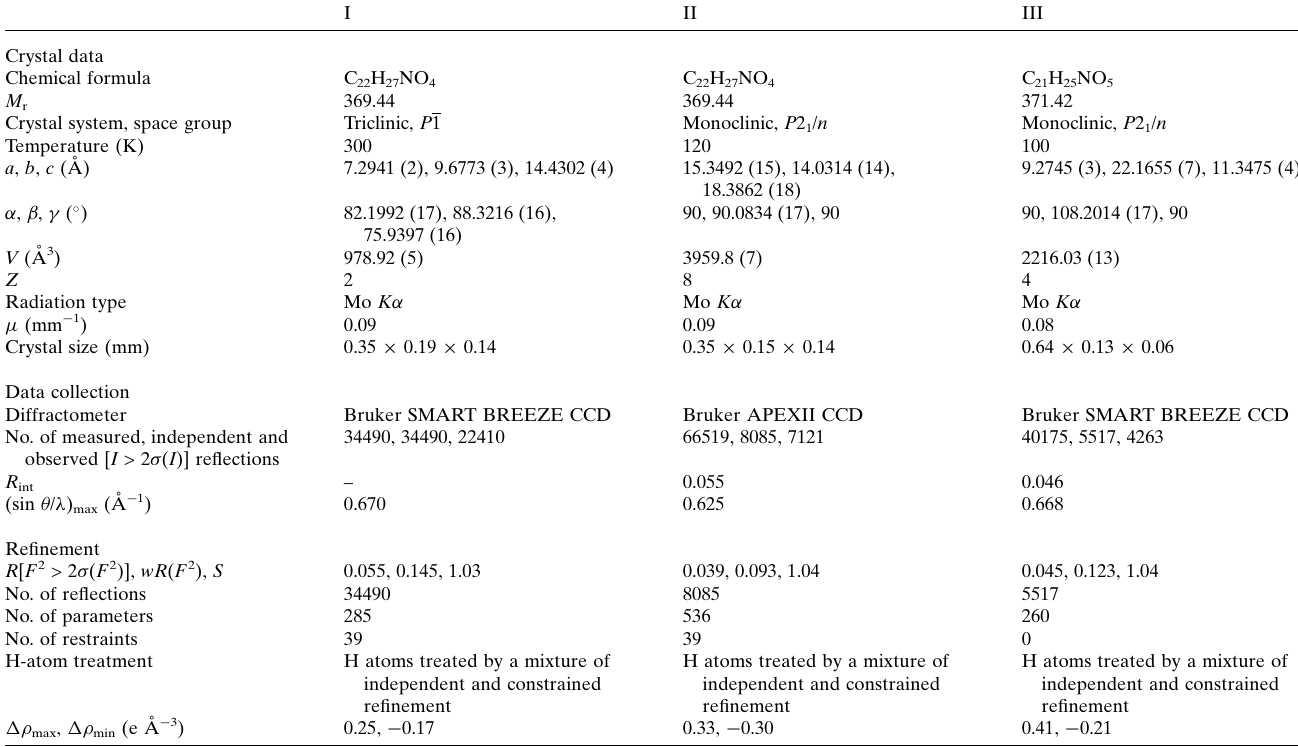
Table 6 Experimental details.